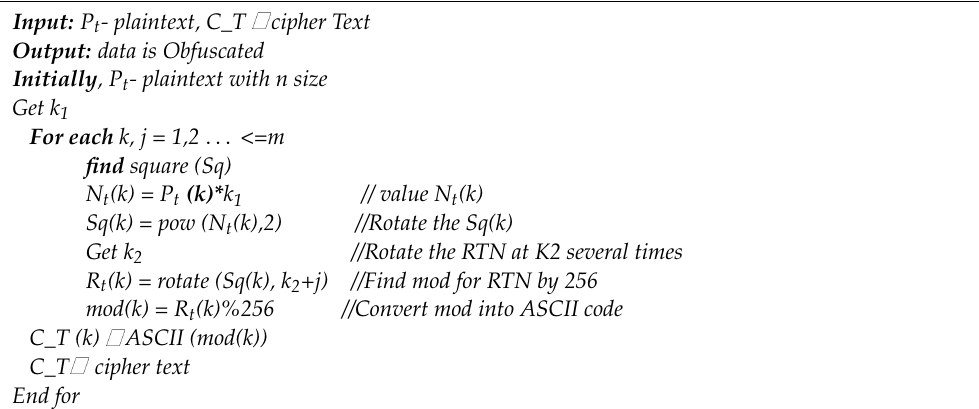
Algorithm 2: Algorithm for Hybrid Data Obfuscation for Security